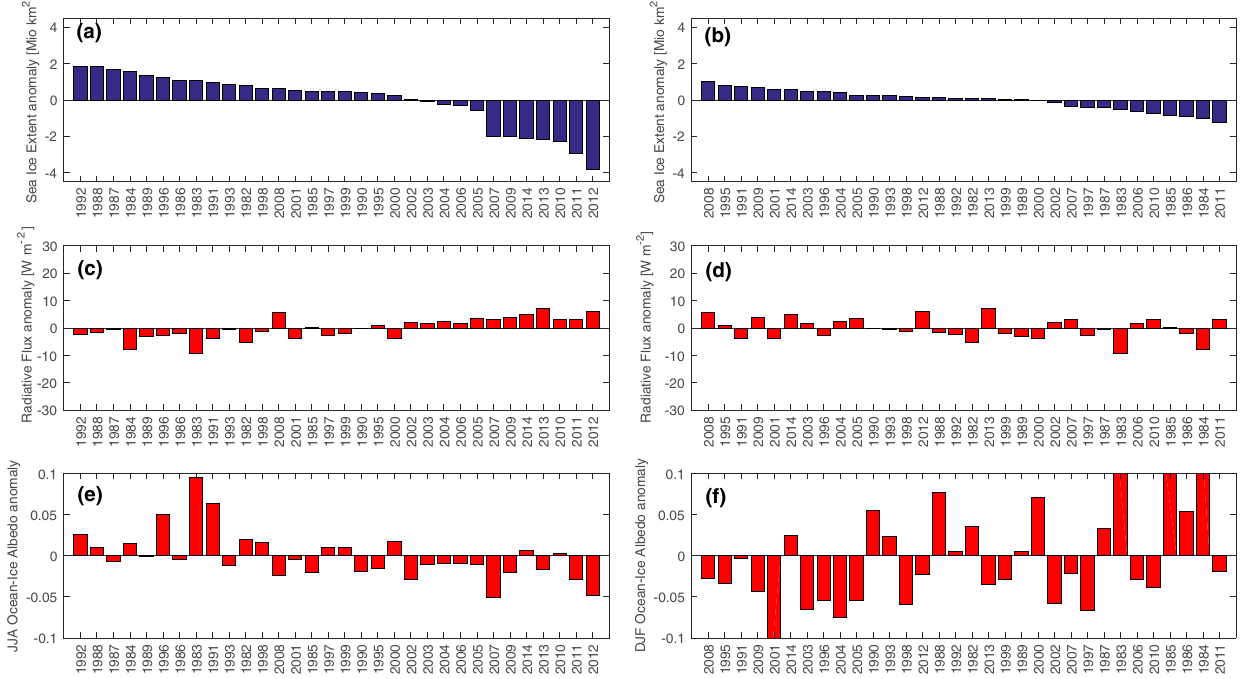
Figure 3. Anomaly of mean absorbed shortwave flux and surface albedo sorted from positive to negative sea ice extent anomaly: Arctic (a, c, e) and Antarctic (b, d, f) sea ice extent anomaly (a, b) , annual anomaly of shortwave flux absorbed by the ice–ocean system poleward of 60 ◦ (c, d) , and summer albedo anomaly (e, f)